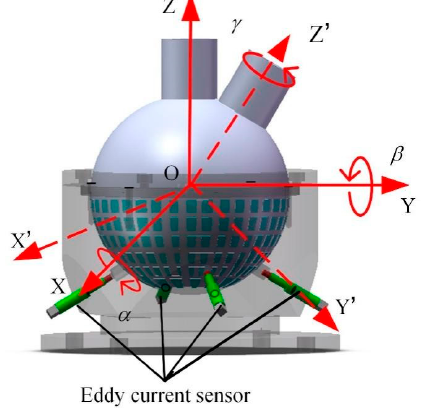
Figure 1. Schematic diagram of measurement system.